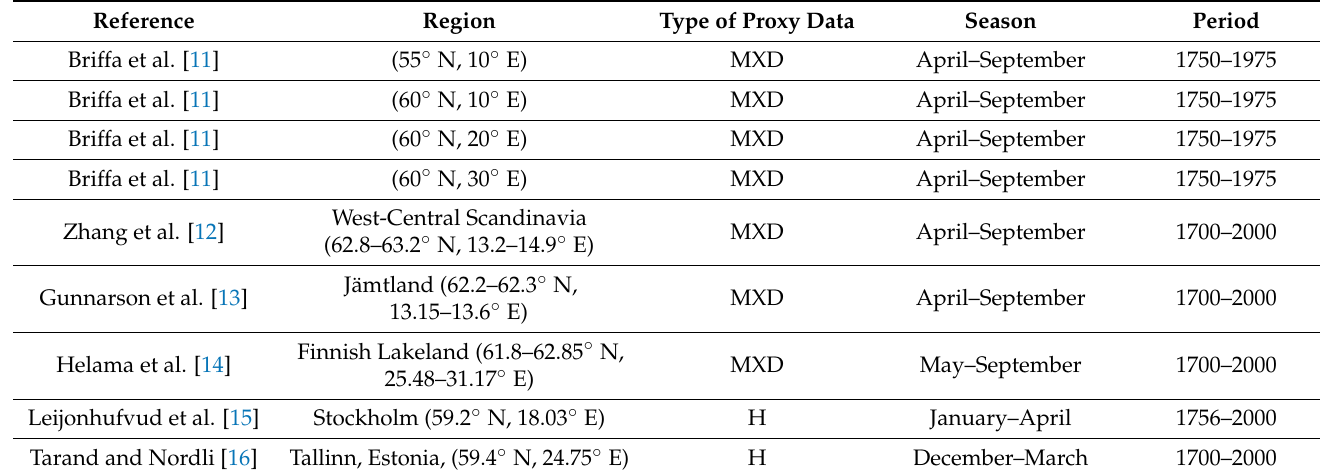
Table 1. A list of proxy records used in this analysis.